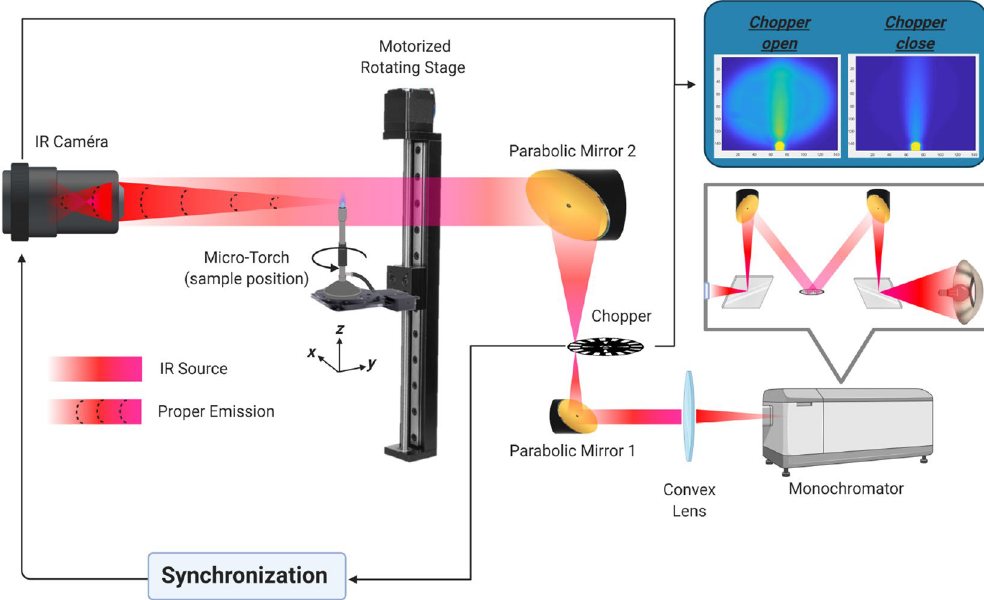
Figure 1. Schematic of the experimental setup. This illustration is made for a micro-torch. (Created with https ://BioRe